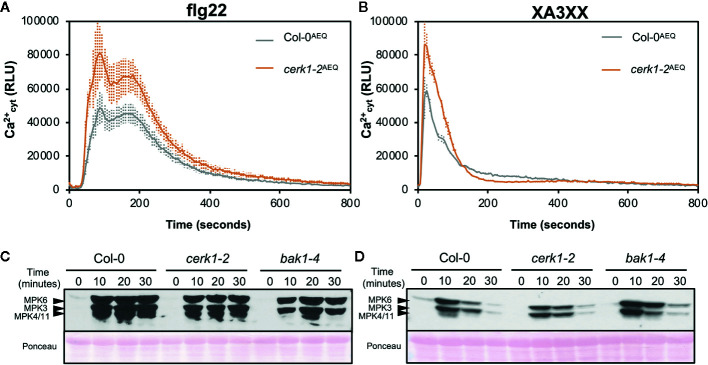
Pattern-triggered immunity hallmarks comparison between flg22 and arabinofuranosyl-xylotetraose (XA3XX). Flg22 (A, B) and XA3XX (C, D) final concentrations were 1 and 500 μM respectively. (A, B) Elevations of cytoplasmic calcium concentrations over time in 8-d-old Arabidopsis Col-0AEQ and cerk1-2
AEQ seedlings upon treatments. Data represent mean ± SD (n=8) from one experiment representative of three independent ones with similar results. (C, D) MAPK activation in 12-d-old Arabidopsis seedlings of the indicated genotypes. The phosphorylation of MPK6, MPK3, and MPK4/MPK11 was determined by Western blot, using the anti-pTEpY antibody, at the indicated time points (minutes) after treatment. Ponceau red-stained membranes show equal loading. Western-blot shown is from one experiment representative of three independent ones with similar results.